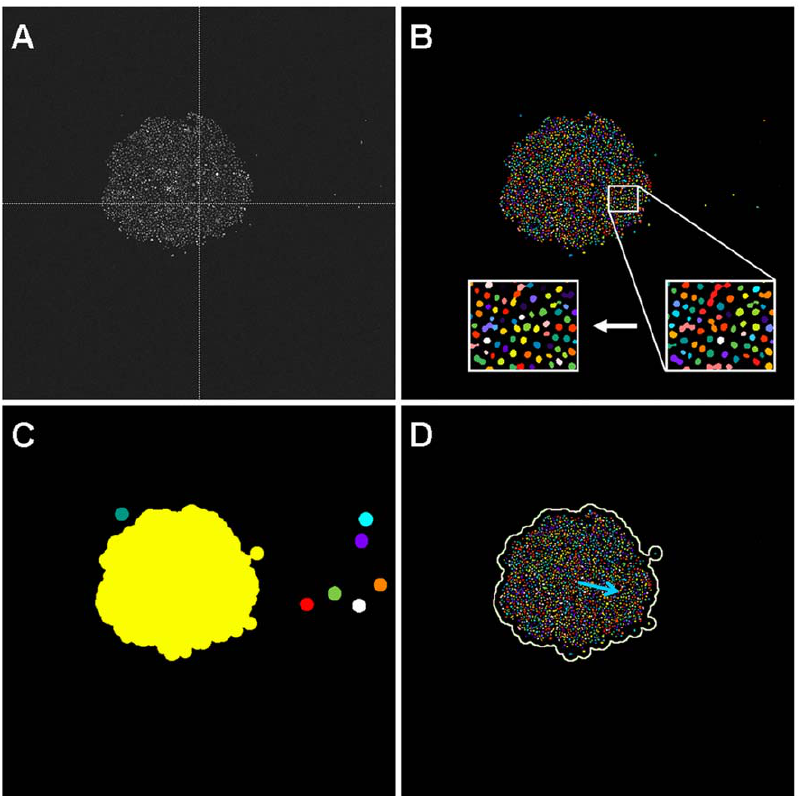
Figure 2. Image processing procedure to determine the cell count and dispersion values of a well. (A) Colony nuclei image of each well was obtained by stitching four adjacent, non-overlapping fields together. The example here shows a primary cell colony surrounded by several cell outliers. (B) Nuclei segmentation, which consists of a wavelet transform and watershed algorithm steps, was applied to identify all nuclei in the well. (C) The nuclei segmentation mask was then dilated to generate merging region areas where distinct cell clusters could be isolated. In general, the largest region (yellow), representing the cell colony of interest, and other smaller regions (other colors), representing outlier cell clusters, were identified. (D) Nuclei within the colony of interest were kept for measurement. Cell count was determined by the total nuclei count within the colony. Cell dispersion was determined by applying the spreading coefficient formula. The blue arrow represents a vector centered on the colony center with distance equal to the spreading coefficient.